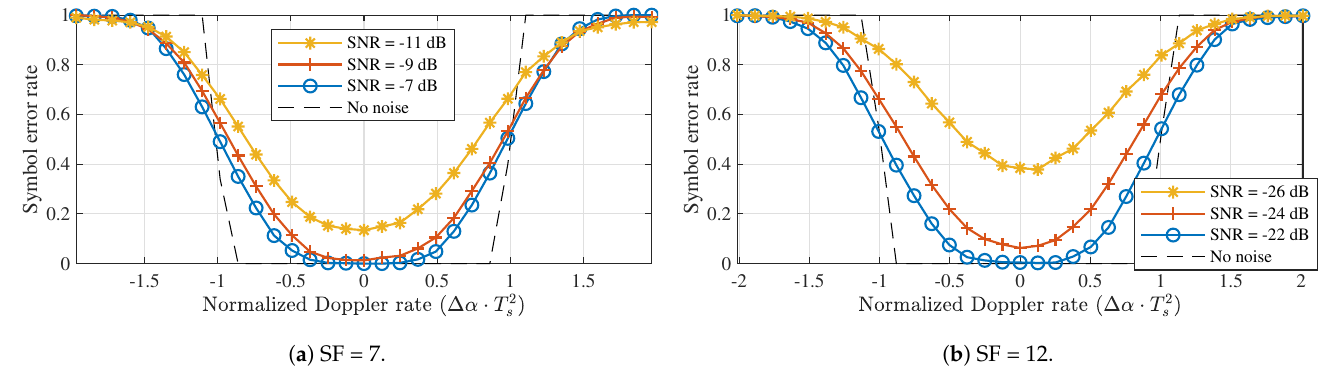
Figure 7. Symbol detection performance for constant Doppler rates when the down-chirp is perfectly time-aligned. ( B =